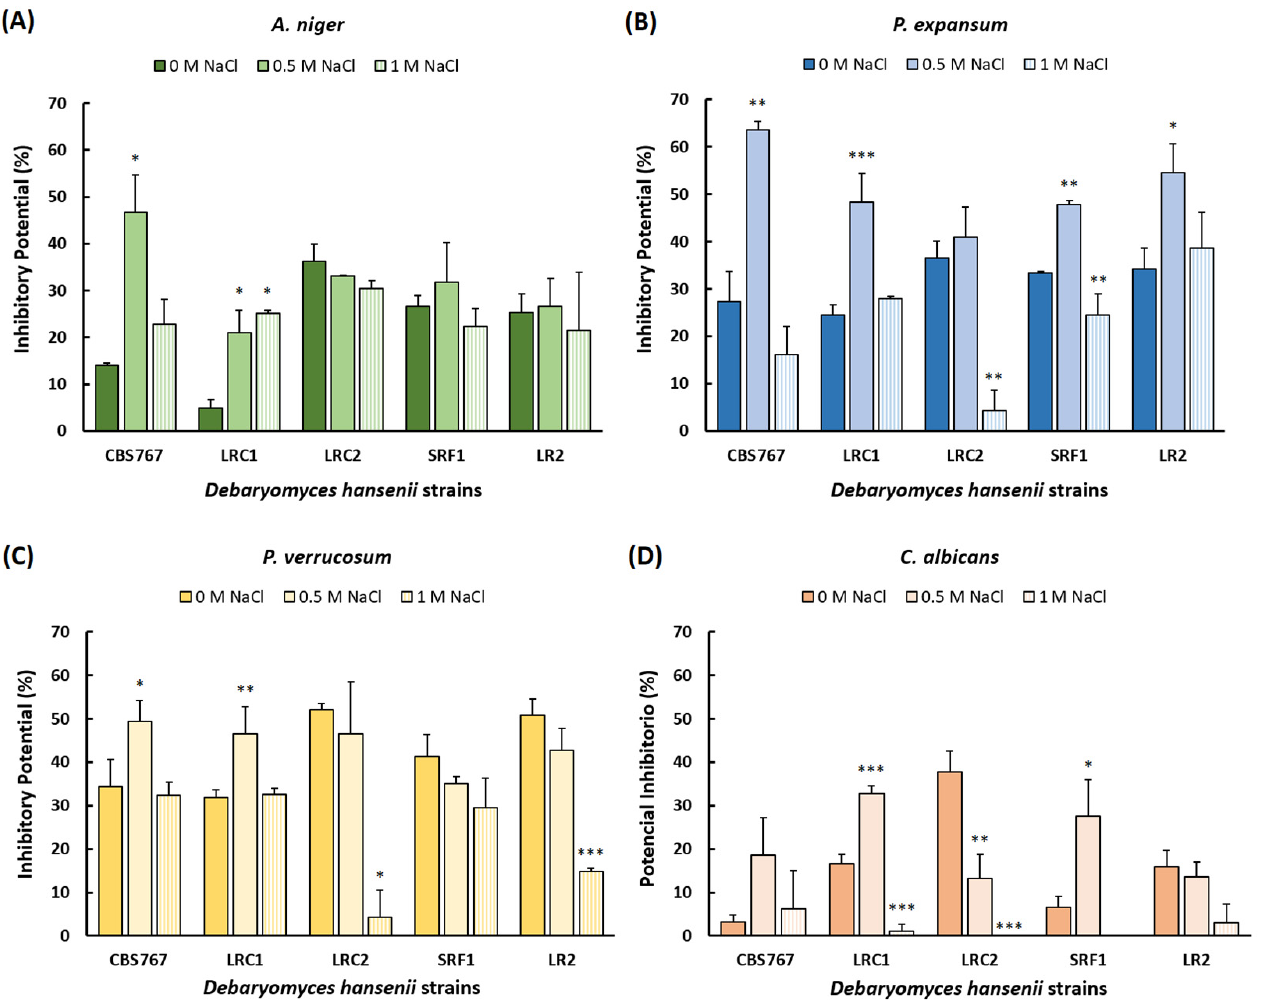
Figure 1. Streak inhibition assay in different microorganisms. ( A – D ) Inhibitory potential (%) of the different strains of D. hansenii in A. niger ( A ), P. expansum ( B ), P. verrucosum ( C ), and C. albicans ( D ). Mean values ± standard deviation obtained in three independent experiments are plotted. Statistical significance shown in the figure (* p < 0.05, ** p < 0.01, *** p < 0.001) represents the most significant data for inhibitory potential values in each selected strain of D. hansenii at different NaCl concentrations (0.5 M and 1 M) compared to the standard (0 M). More detailed statistical analysis can be found in the supplementary data (Tables S2 and S3).